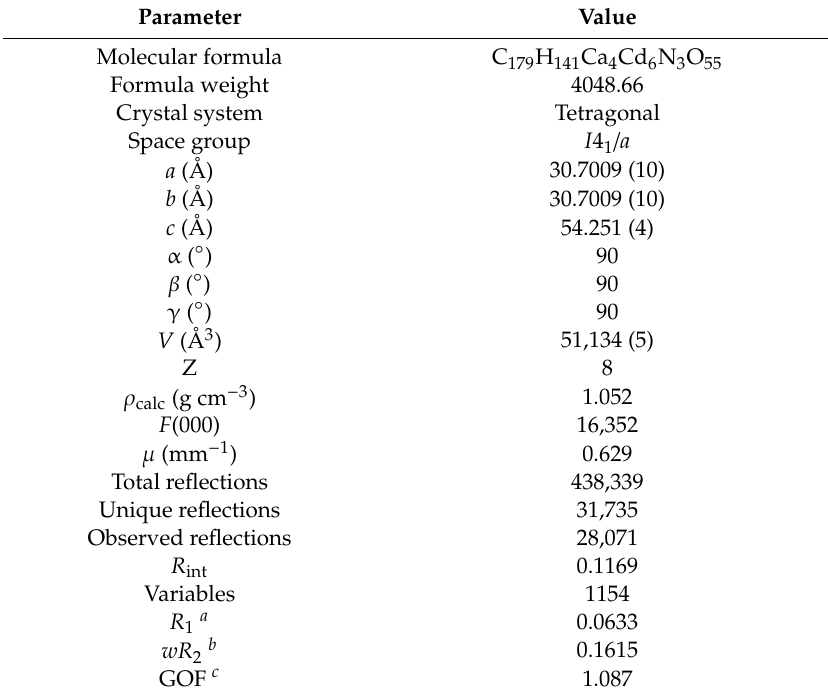
Figure 3. The 1D branched-chain SBU of MOF 1 propagated along the crystallographic a direction with associated BTB ligands ( a ) and metal skeleton ( b ). All disordered components, dissociated DEF solvate, and hydrogen atoms are omitted for clarity. Color legend: C: black, O: red, Cd1/Cd2: orange, Cd3: magenta, Ca1: green, Ca2: cyan, Ca3: blue. Table 1. Crystallographic data and refinement parameters for MOF 1 .